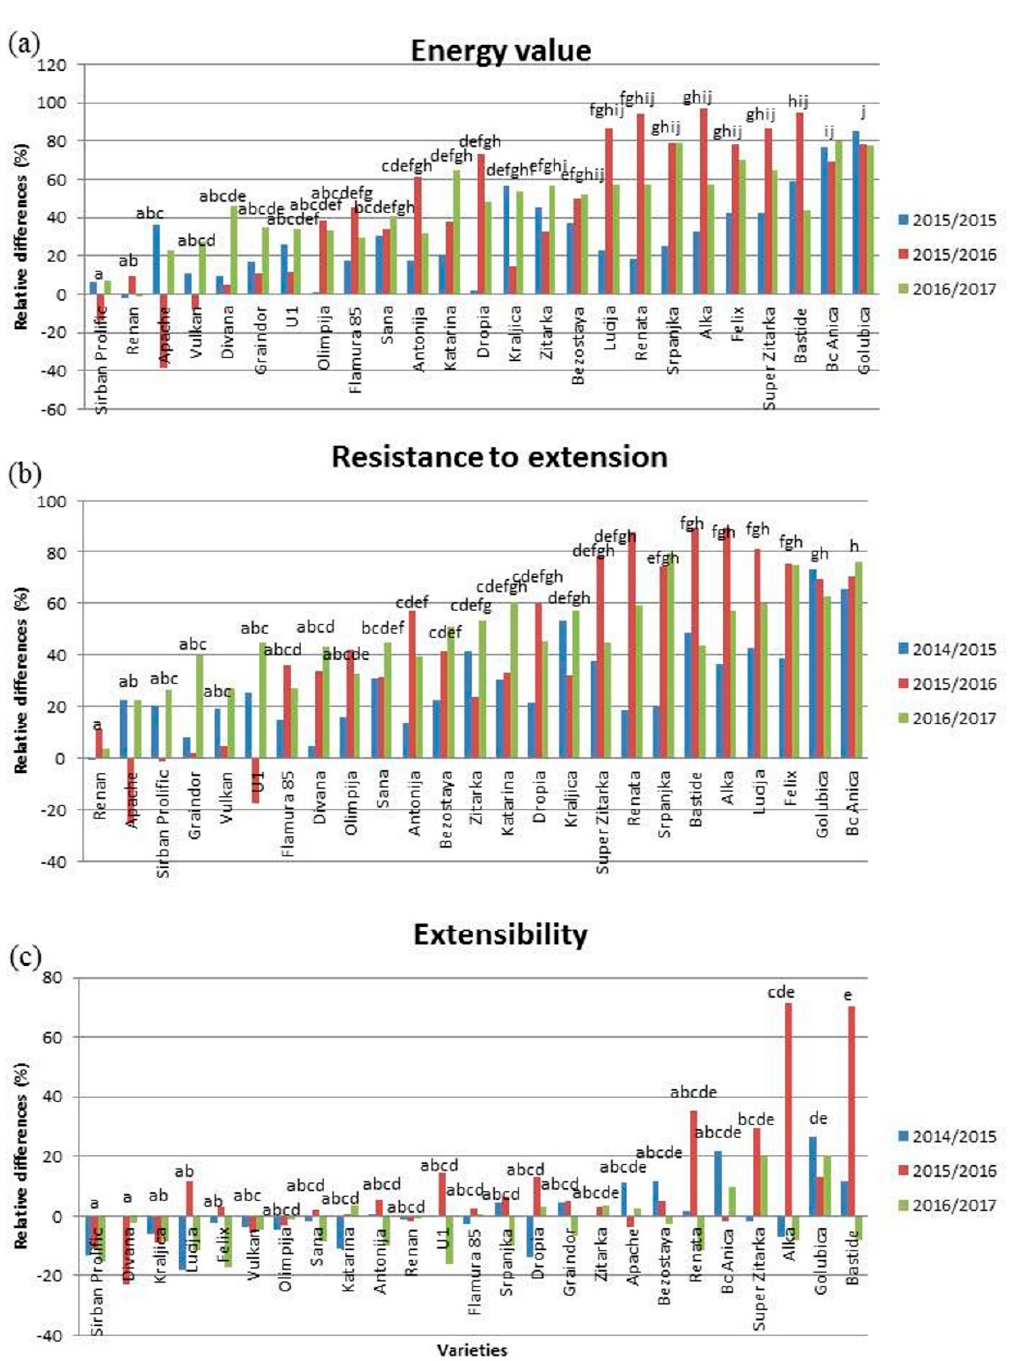
Figure 6. Relative differences of extensograph parameters (energy ( a ), resistance to extension ( b ), and extensibility ( c ) between FHB-inoculated and naturally infected samples in the three years of study (2014/2015, 2015/2016, and 2016/2017) for 25 winter wheat varieties. Different lower-case letters represent significantly different values ( p < 0.05) for each wheat variety in three years in average.